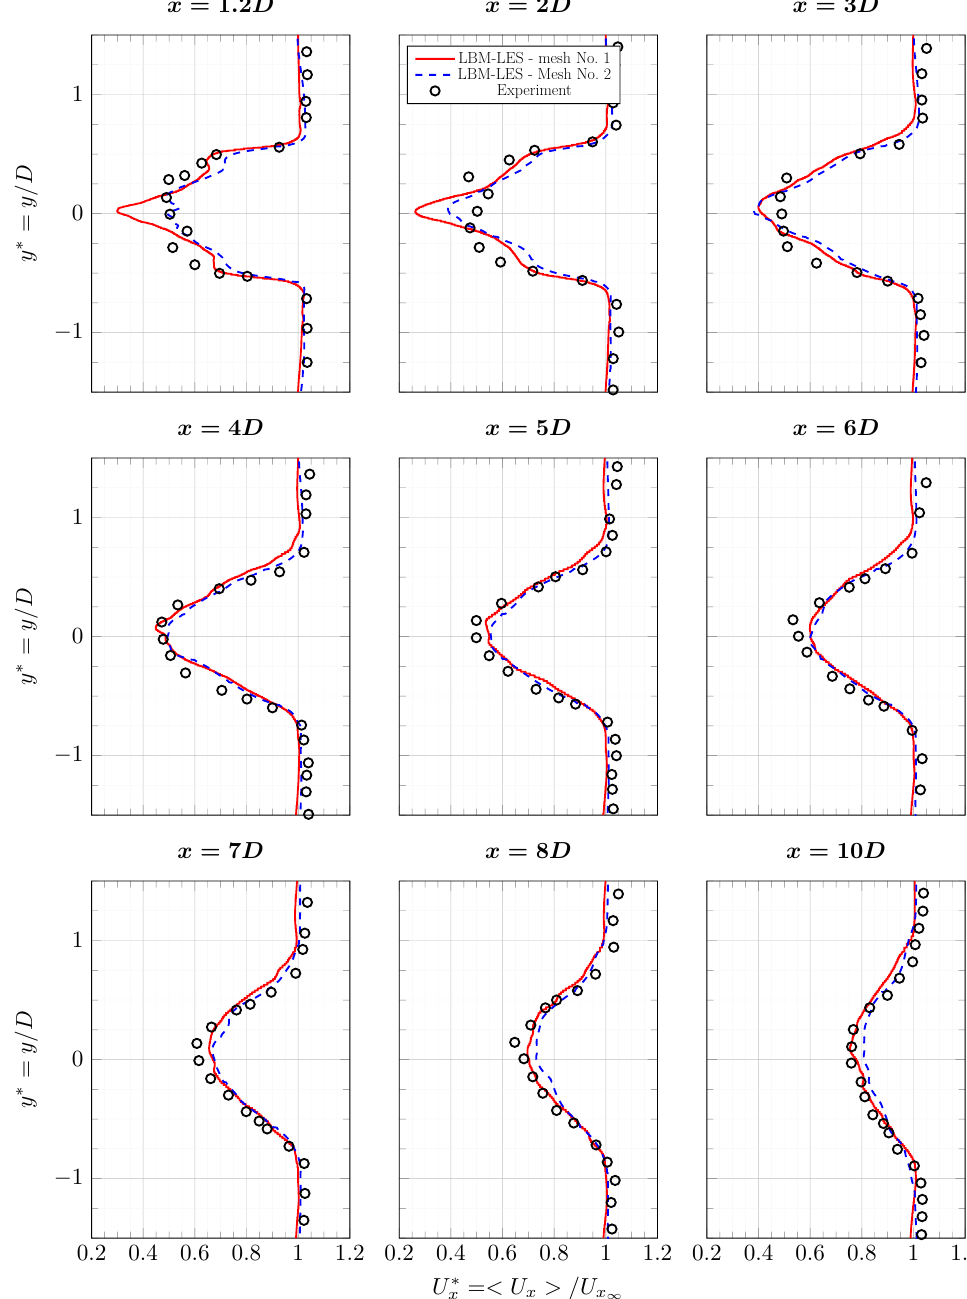
Figure A1. Average axial velocity profiles in the wake of the tidal turbine at TSR = 3.67 and I = 3%. Results are from experiment [6] and from LBM-LES simulations with mesh Nos. 1 and 2. Complete profile